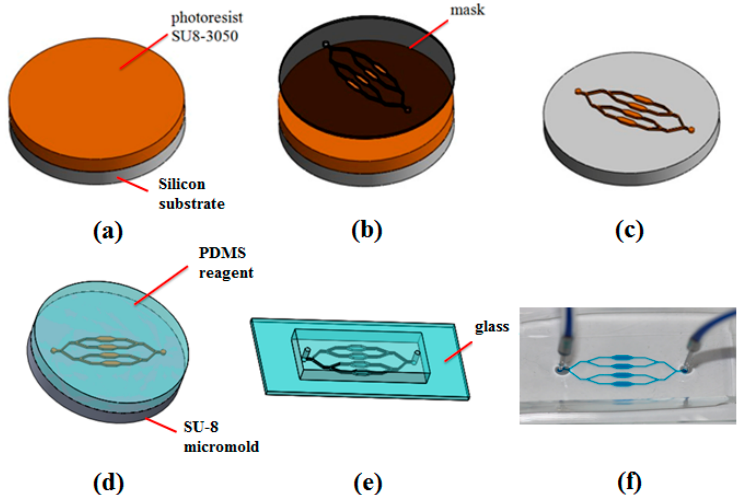
Figure 1. Schematic illustration of SU-8 micromold fabrication procedure: ( a ) silicon wafer cleaning and spin coat SU-8, ( b ) UV exposure, ( c ) SU-8 development and PDMS replication process, ( d ) casting and spin coat SU-8; ( b ) UV exposure; ( c ) SU-8 development and PDMS replication process; the PDMS on SU-8 micromold, ( e ) O 2 plasma bonding PDMS layer with glass substrate, and ( d ) casting the PDMS on SU-8 micromold; ( e ) O 2 plasma bonding PDMS layer with glass substrate; ( f ) photography of PDMS microchannel with blue color dye injection. and ( f ) photography of PDMS microchannel with blue color dye